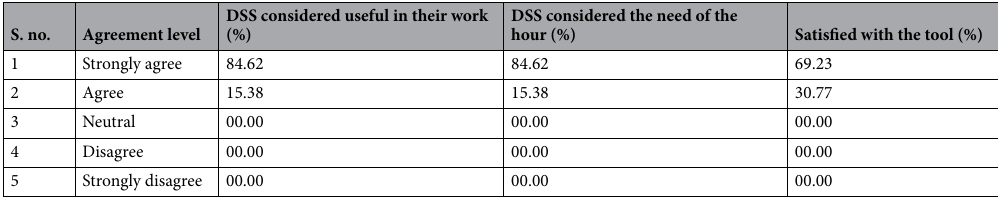
Table 3. Beta testing